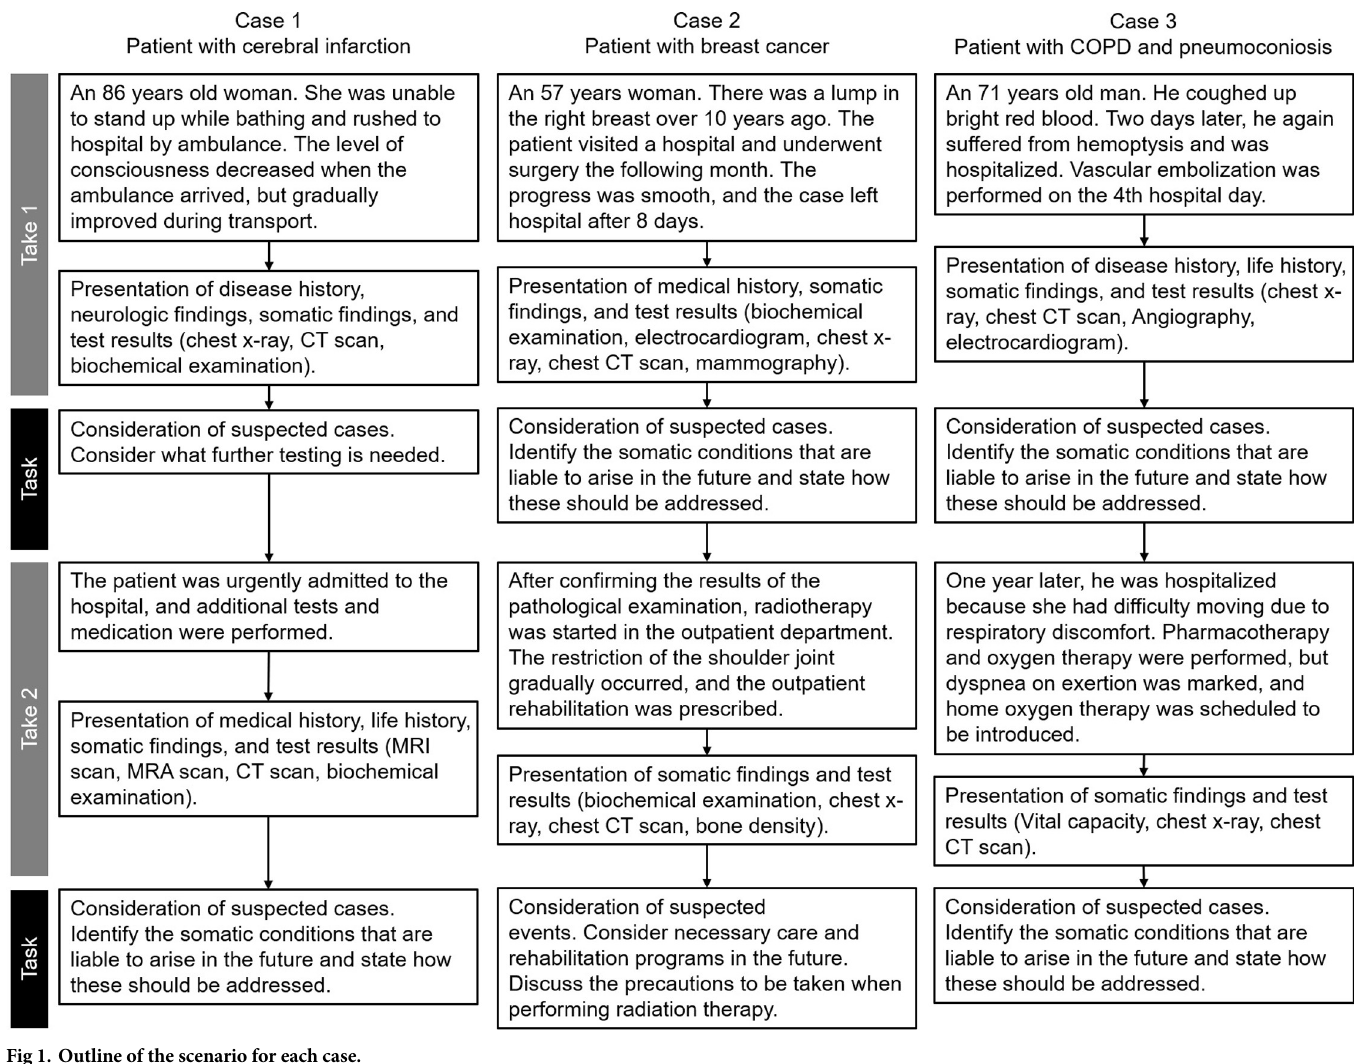
Fig 1. Outline of the scenario for each